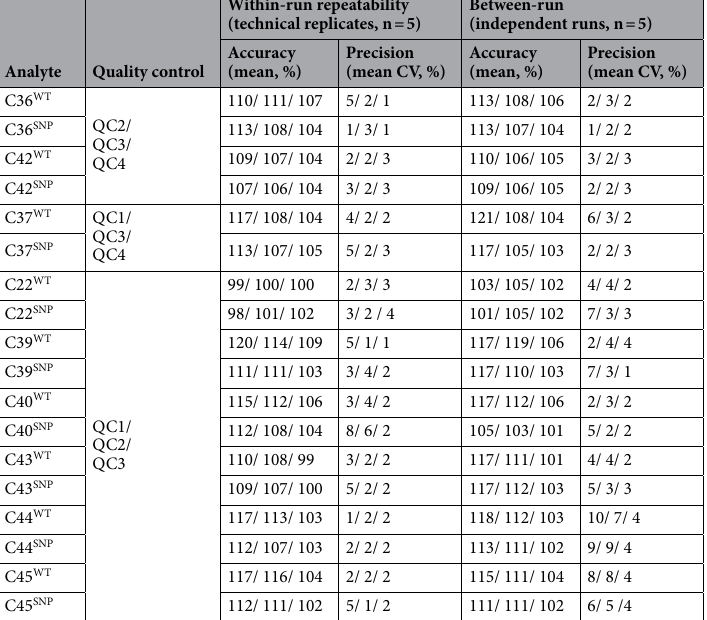
Analyte Quality control